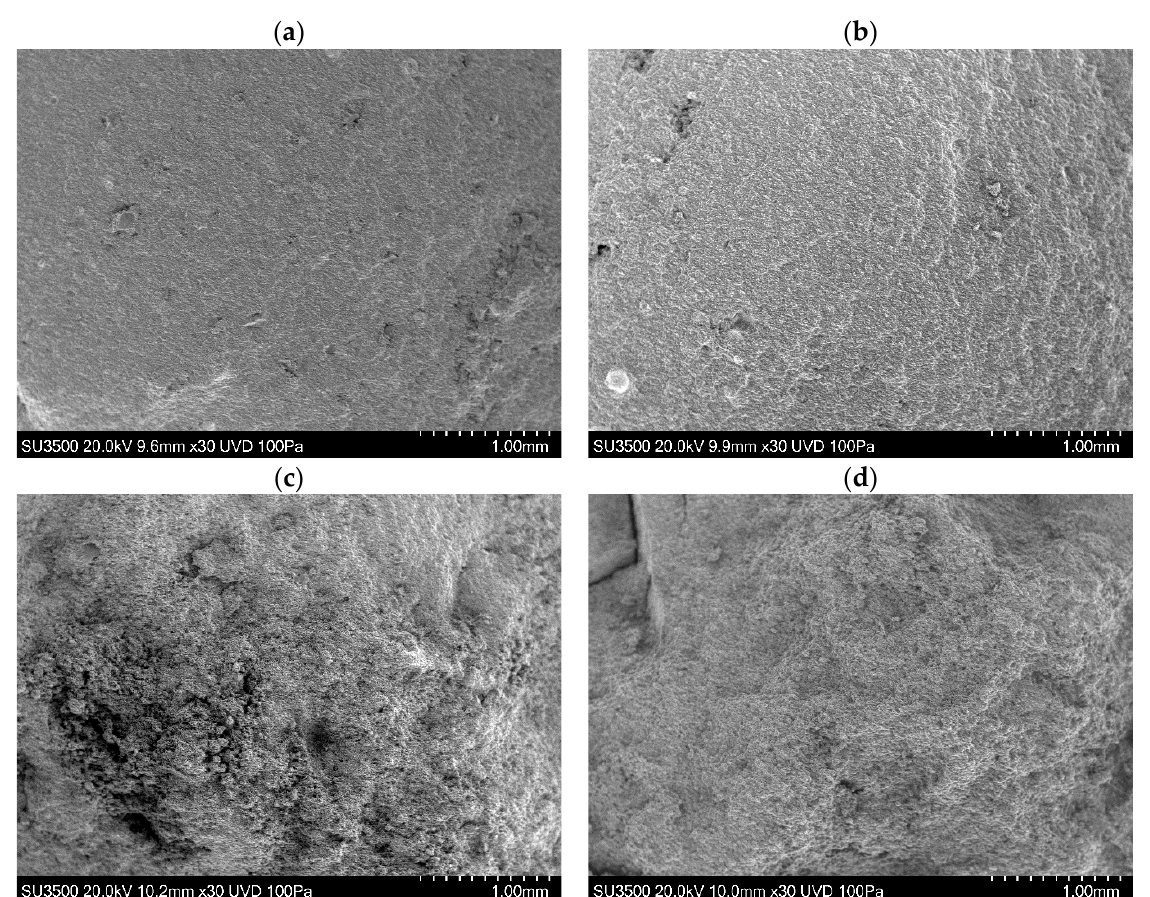
Figure 10. SEM Images of Ash B with different chemical composition. ( a ) Specimen tested at 400 °C—Brittle; ( b ) Specimen tested at 460 °C—Brittle; (c) Specimen tested at 475 °C—Ductile; ( d ) Specimen tested at 500 °C—Ductile.